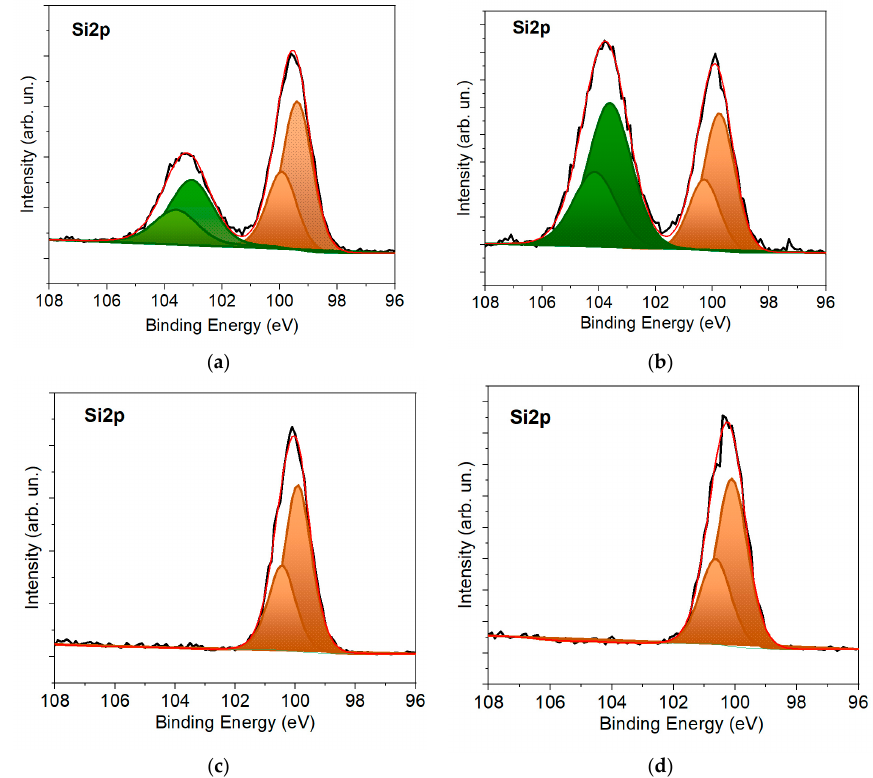
Figure 4. XPS Si2p spectra for ( a ) virgin p-Si with native oxide layer; ( b ) laser-doped n + p-Si with formed oxide layer; ( c ) virgin p-Si after HF solution treatment, and ( d ) laser-doped n + p-Si after HF solution treatment.